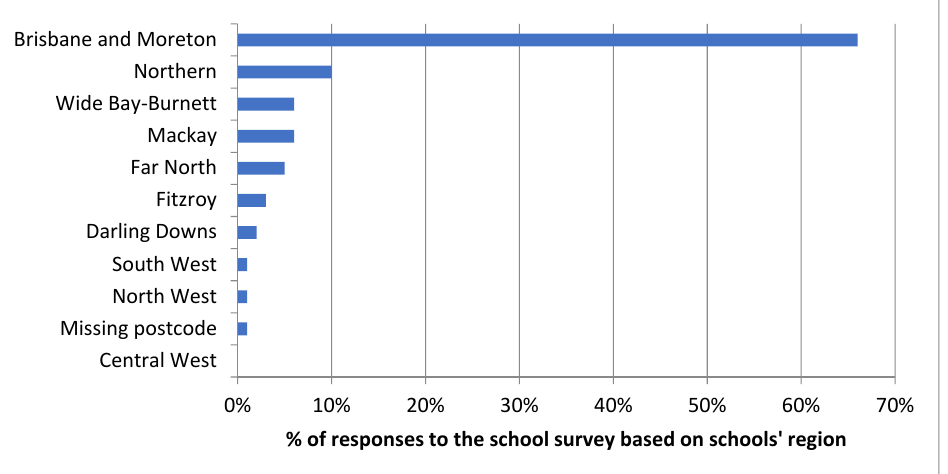
Figure 1. Distribution of the responses to the Ed-LinQ school survey by schools’ region in Queensland ( n = 186). According to the AIL, 63.7% ( n = 121) of the school representatives that answered the survey knew of the Ed-LinQ initiative. However, only 28% ( n = 52) of the respondent schools scored over 3 in AIL (Allocation and Provision, Routinisation), which means that the school provided services, interventions and/or technologies directly related to the ob- jectives of the Ed-LinQ initiative (Figure 2).